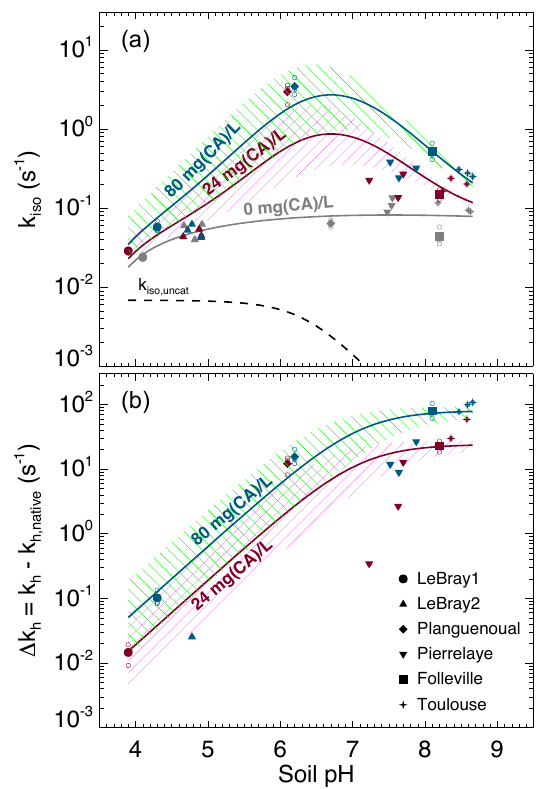
Figure 6. (a) Measured CO 2 –H 2 O isotopic exchange rates ( k iso ) in the different soils for different levels of α -CA addition and (b) as- sociated enhancement hydration rates ( k h − k h , native ) caused by the α -CA addition. In (a) , the un-catalysed isotope exchange rate ( k iso , uncat ; see Uchikawa and Zeebe, 2012) is shown for reference (black dotted curve). The pH dependence of the native isotope ex- change rates (grey points in a ) is interpolated over the entire pH range explored here using a third-order polynomial fit (grey curve in a ). The range of the theoretical rates above this native rate curve that we would expect from α -CA addition of 24mgL − 1 (purple curve and hatched area) and 80mgL − 1 (green curve and hatched area) are also shown and have been obtained using k cat /K M = 30 ± 5s − 1 µM − 1 and pK a = 7 . 1 ± 0 . 5. For those microcosms that were measured multiple times (several sequences), smaller open symbols are displayed to indicate the results from each individual sequence. In some cases (e.g. LeBray 2), some points could not be displayed in (b) because the k iso measured after CA addition was smaller than the mean native k iso , resulting in negative (cid:49)k h values (within the measurement